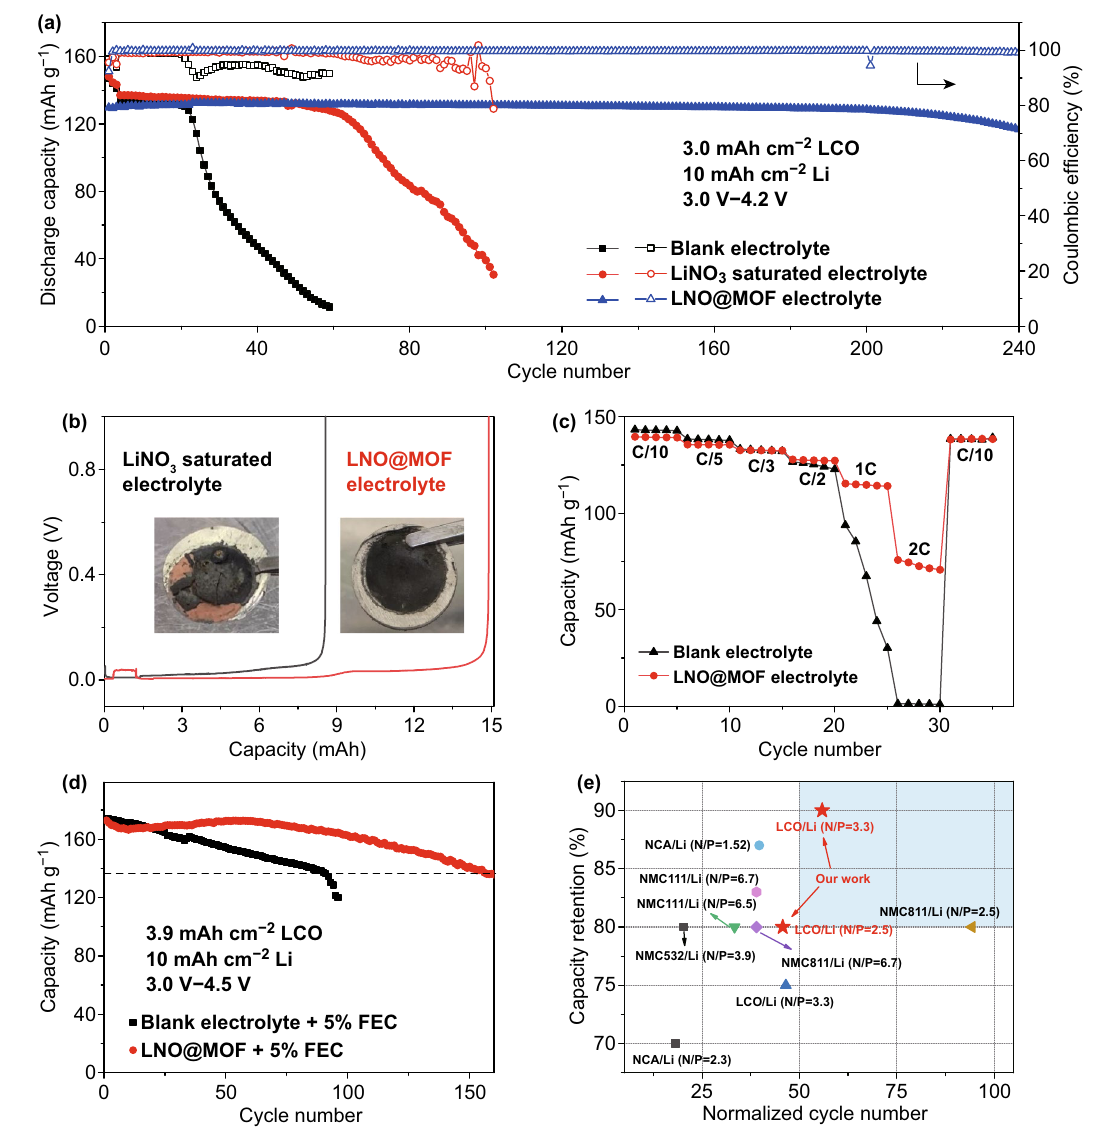
Fig. 4 a Long-term cycling performance of a practical LCO|Li full cell with a N/P ratio of 3.3, cycled at 0.2 C charge/0.5 C discharge. b Quan- tification of remaining active Li after cycling. Inset: optical images of the Li anode disassembled from the cycled LCO|Li cell in ( a ). c Rate performance of LCO|Li full cell in different electrolytes. d Long-term cycling performance of LCO|Li full cell with a N/P ratio of 2.5, cycled at 0.2 C charge/0.5 C discharge with 5% FEC additive. e Summary of capacity retention of practical high-voltage LMBs shown in Table S2. The normalized cycle number refers to the total cycle number divided by the equivalents of total active Li with respect to cathode (i.e., N/P ratio plus one). The shadow region indicates a capacity retention higher than 80% after 200 cycles with a N/P ratio below